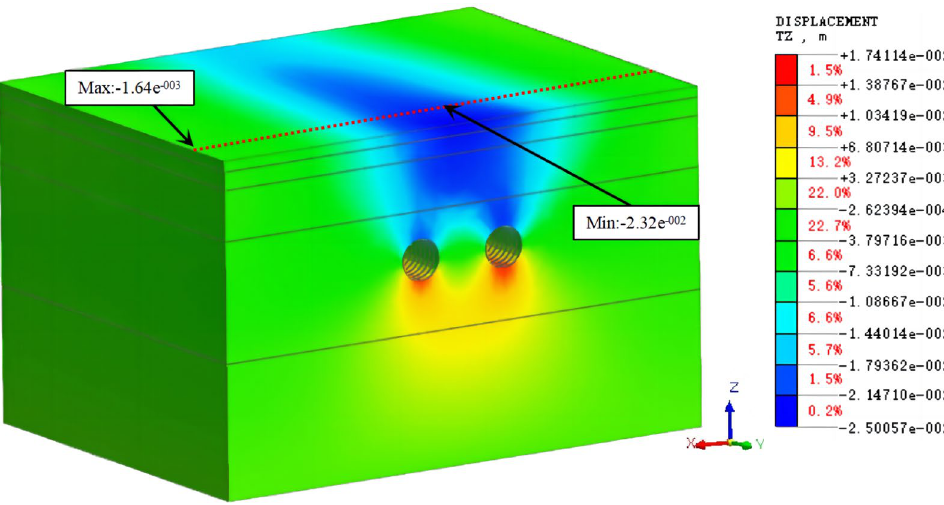
Figure 10. The cloud diagram of the vertical displacement for working condition 1 (excavation of both tunnels).